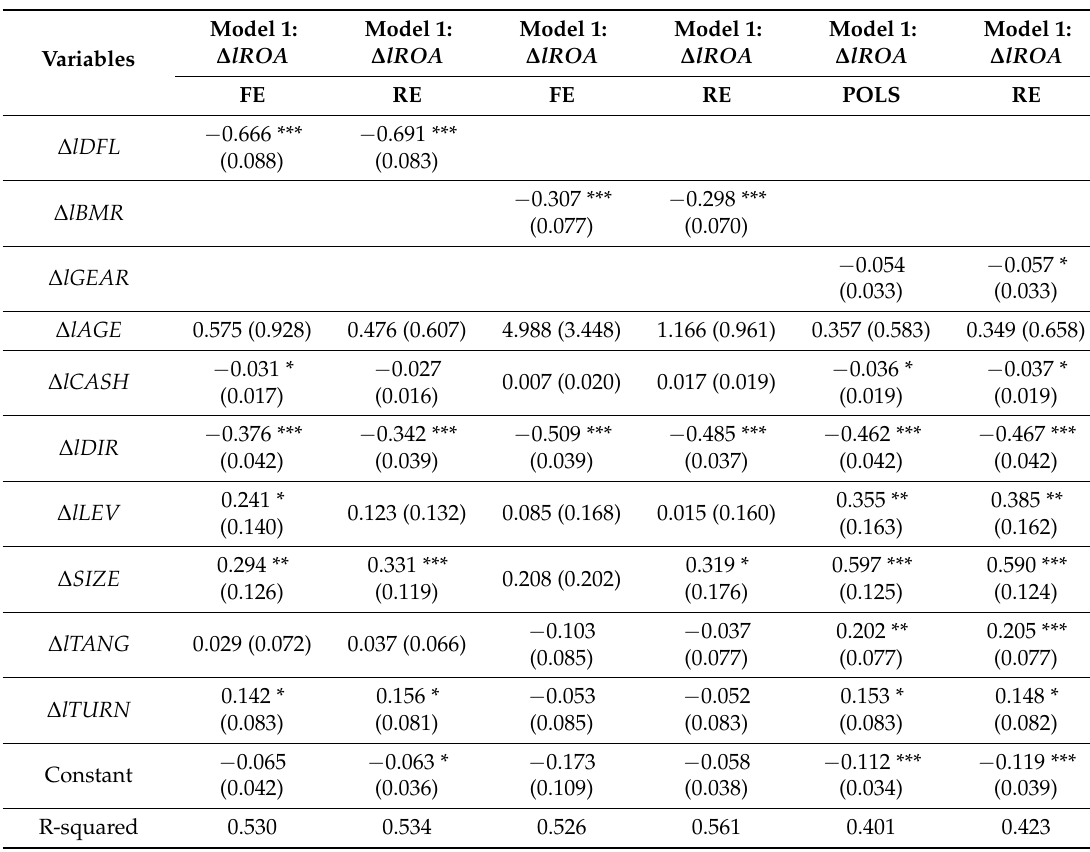
Table A6. Selection of the most appropriate estimator for the robustness analysis (Model